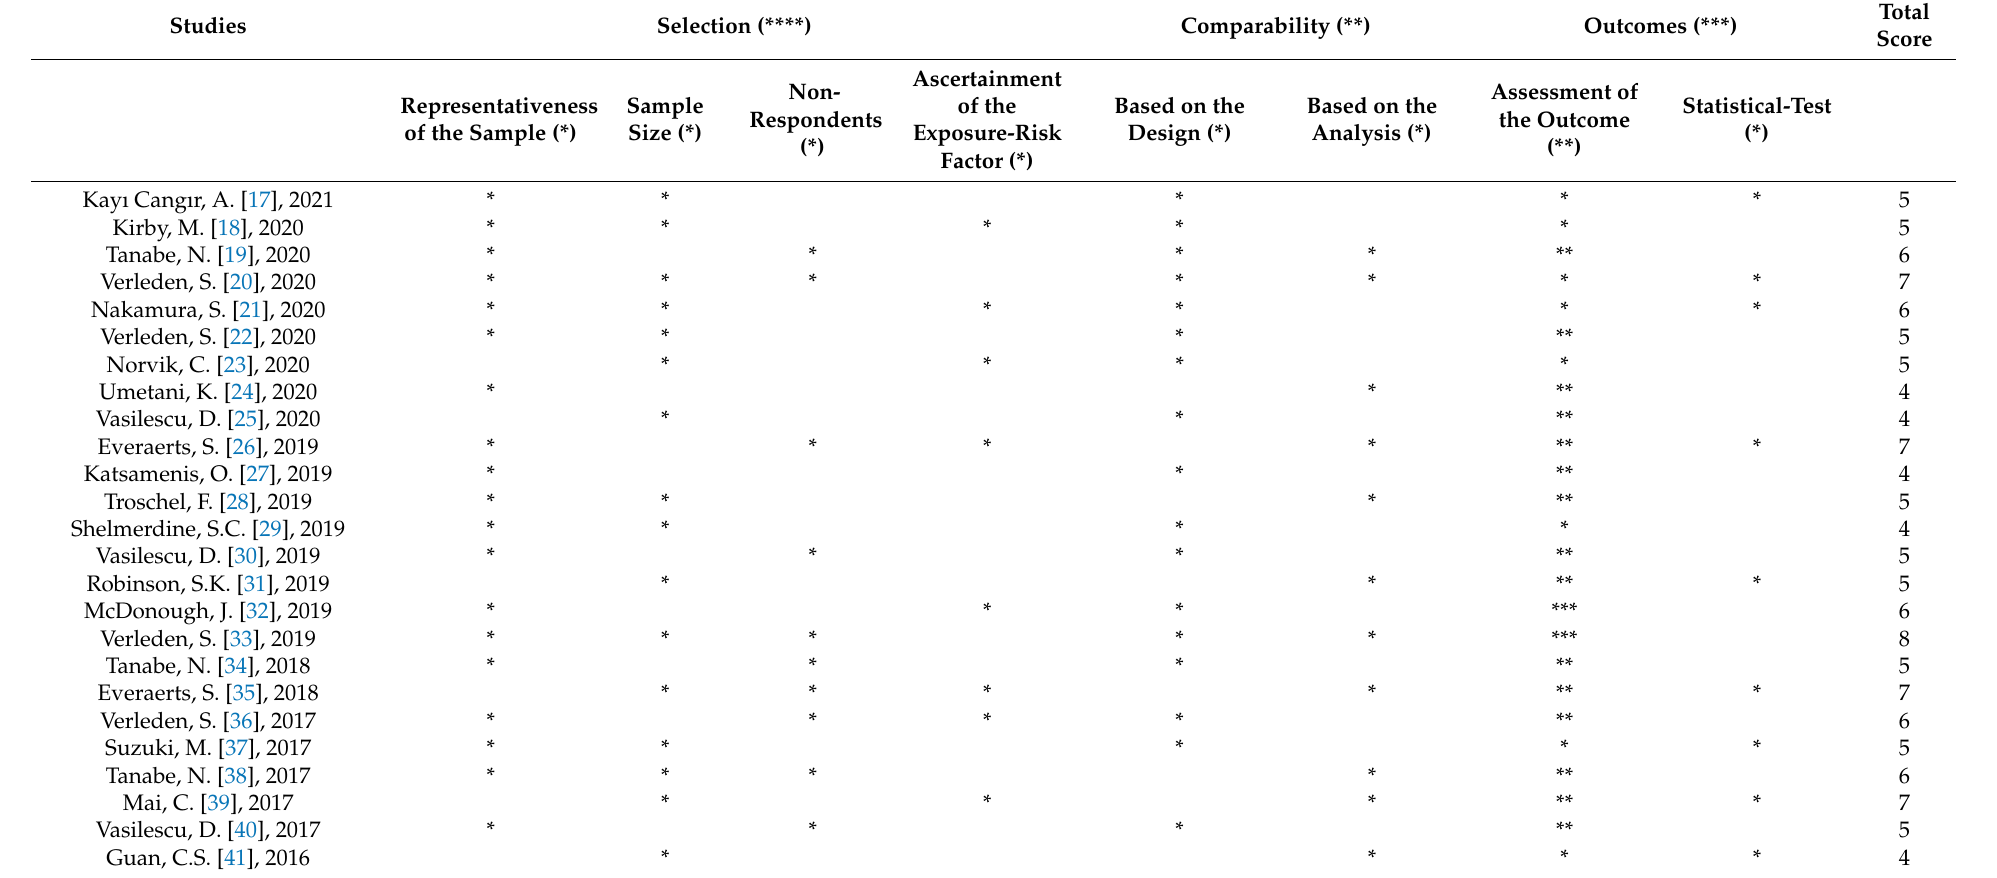
Table 1. Newcastle–Ottawa quality assessment scale for observational